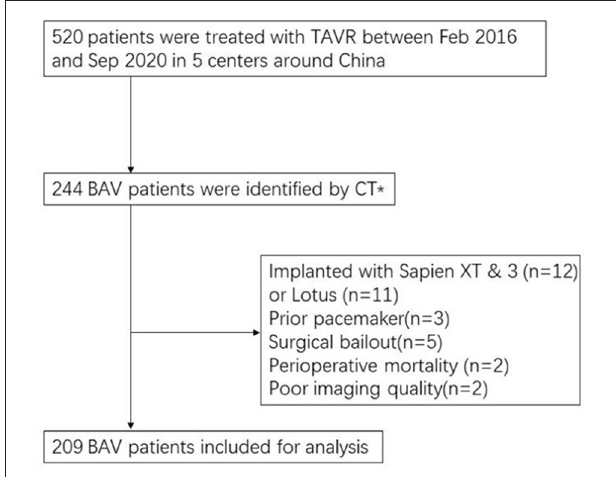
FIGURE 1 | Flow chart of study population. TAVR, Transcatheter aortic valve replacement. *CT classification: bicuspid patients were classified into “bicommissural non-raphe-type,” “bicommissural raphe-type,” and “tricommissural raphe-type BAV” according to pre-procedural multislice computed